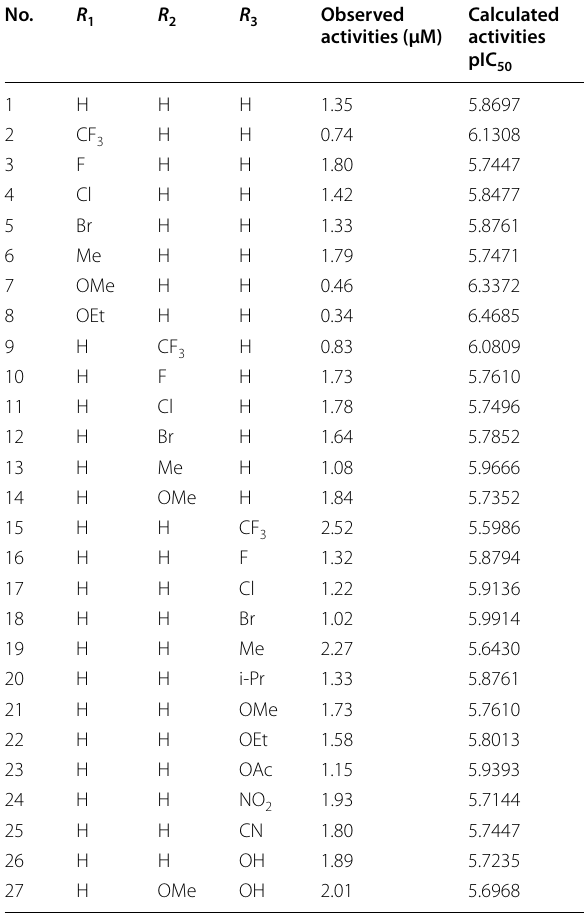
Table 1 The inhibitory concentration of parthenolide derivatives for template molecule